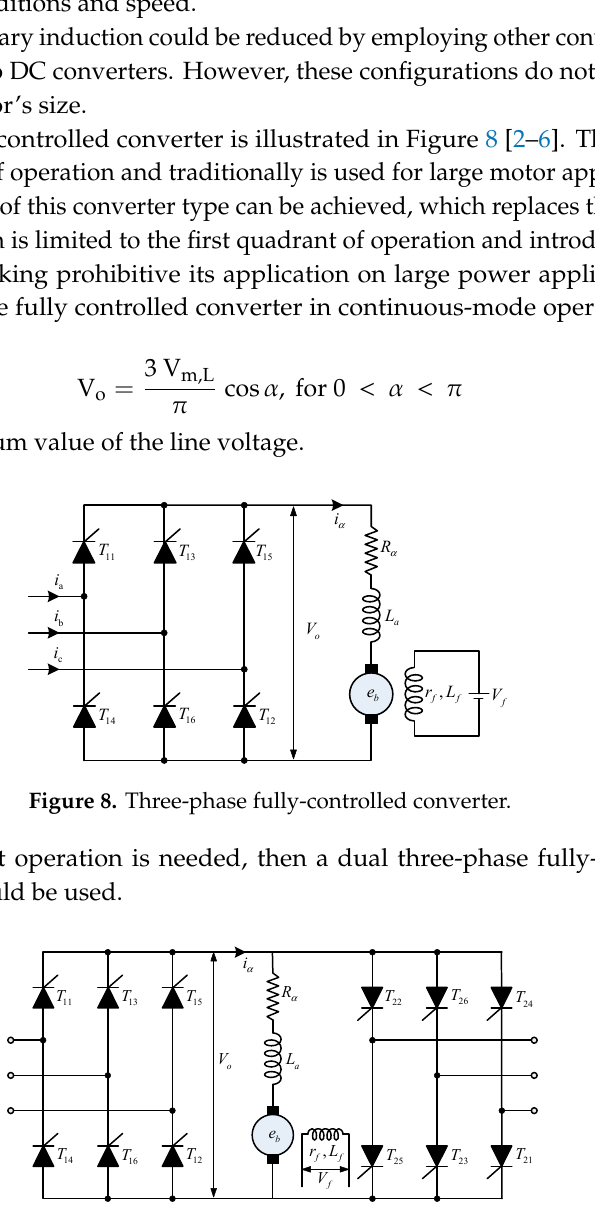
Figure 9. Dual Three-phase fully-controlled converter.